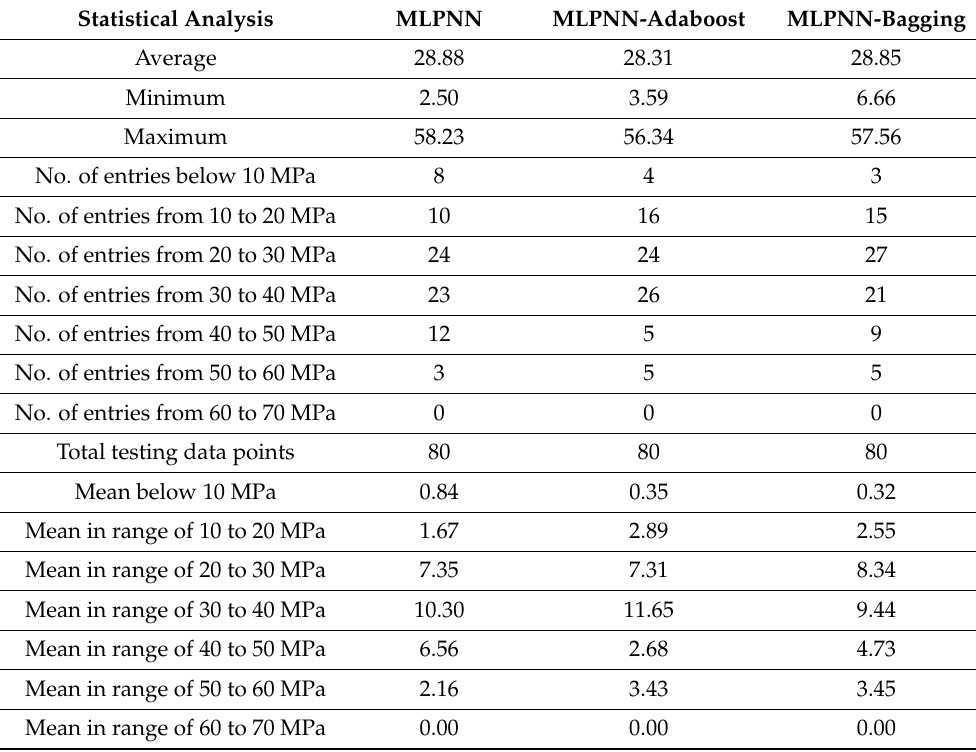
Table 11. Statistical analysis of compressive strength MLPNN model.